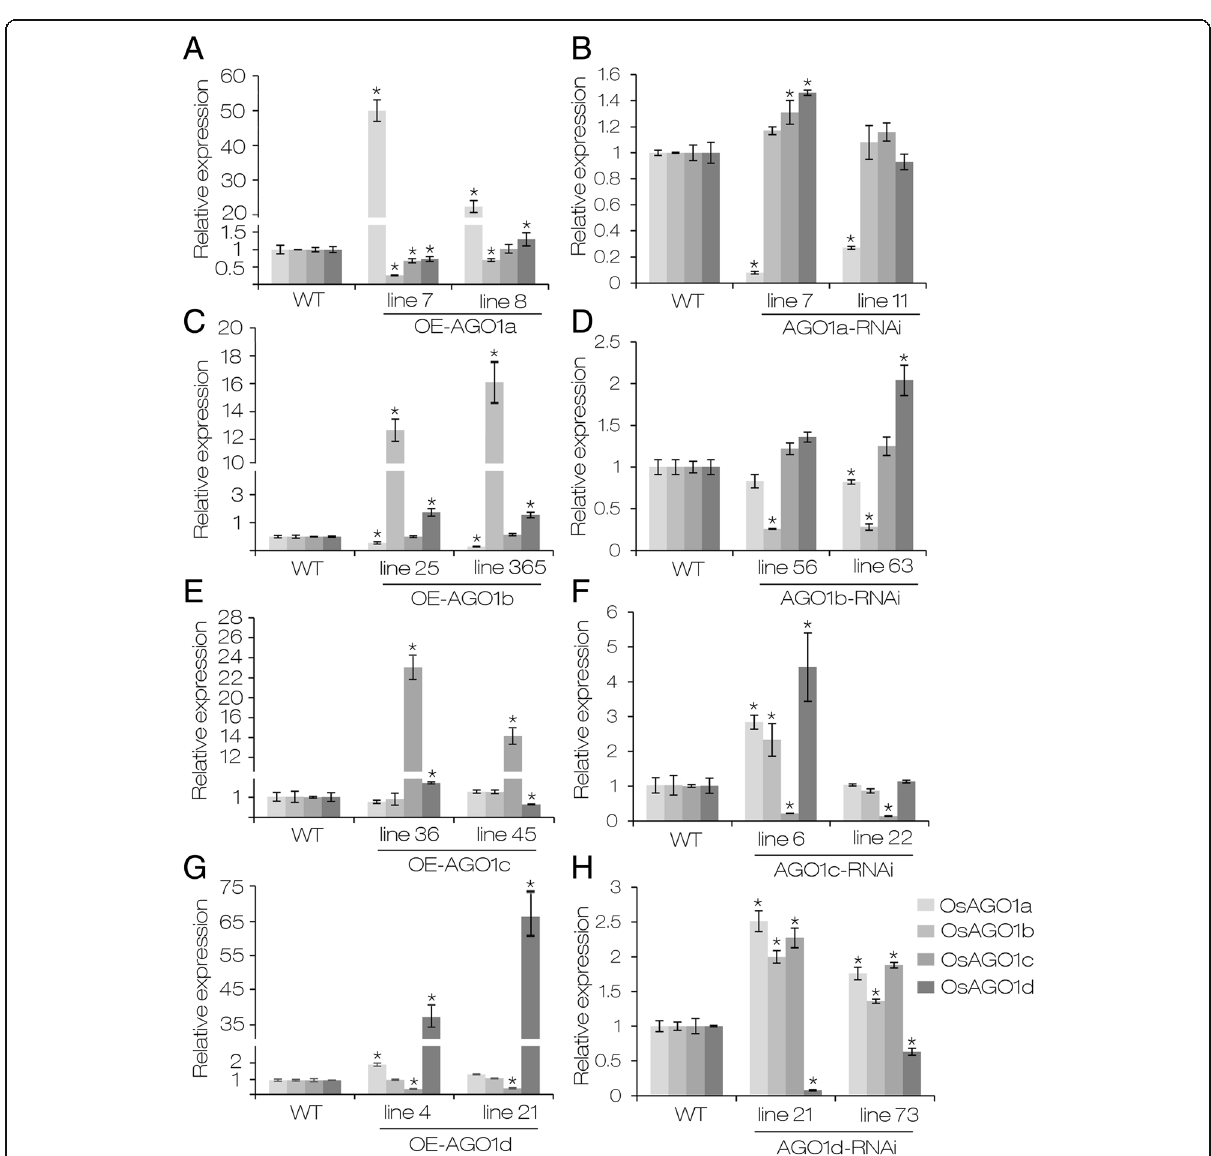
Fig. 4 Relative expression of four AGO1 genes in different overexpression and RNAi lines of OsAGO1s . a , c , e , g Relative expression of four rice AGO1 genes in OE- AGO1a , OE- AGO1b , OE- AGO1c and OE- AGO1d lines. b , d , f , h Relative expression of four rice AGO1 genes in AGO1a -RNAi, AGO1b -RNAi, AGO1c -RNAi and AGO1d -RNAi lines. Flag leaves at the heading stage were used for RNA extraction and qRT-PCR analysis. Means ± SD are given in ( a-h ) ( n = 3). WT, wild type Zhonghua 11; OE, overexpression. * P < 0.05 (one-way